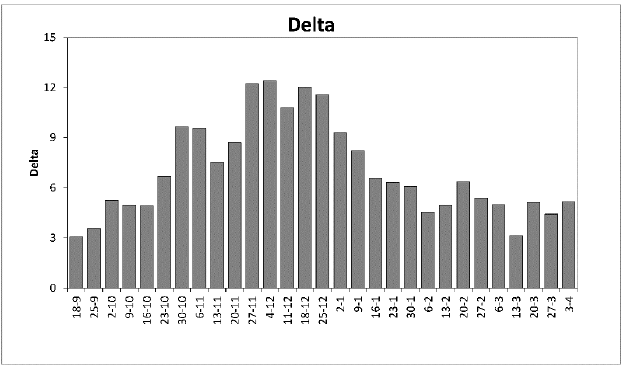
Fig. 3: Evolution of ΔE ab in Eureka and Verna; mean values for the six